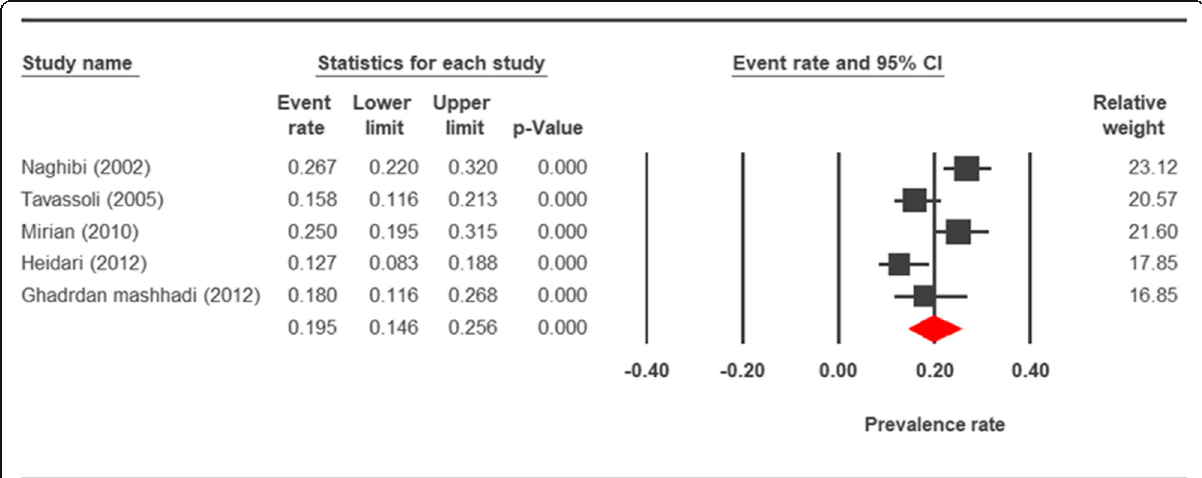
Fig. 3 Forest plot diagram showing the prevalence rate of Cryptosporidium infection in horses of Iran